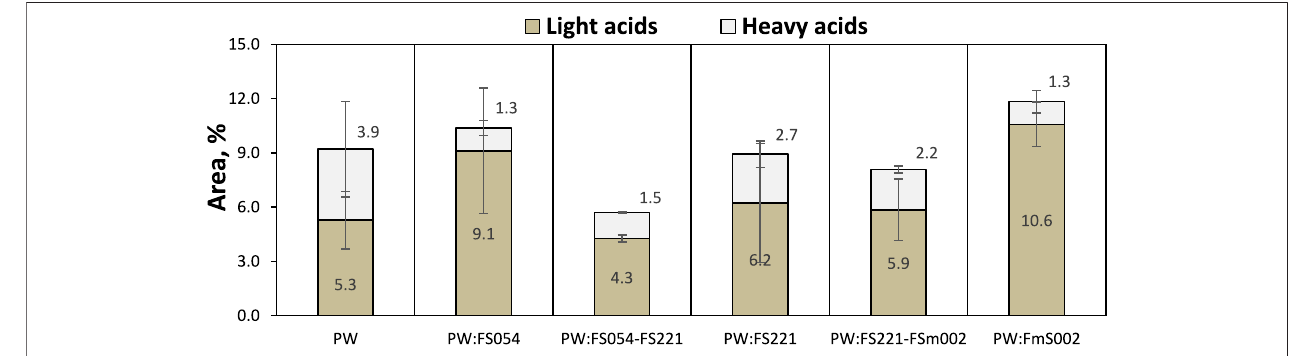
FIGURE 11 | Effect of α -Fe 2 O 3 particle size on the distribution of acids after CFP of PW. Aliphatic acids with C < 4 were classi fi ed as light acids, whereas aliphatic and cyclic acids with C > 4 were grouped as heavy